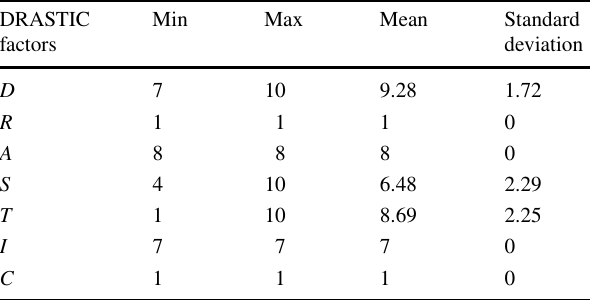
Table 9 Statistics on sensitivity to removing one DRASTIC param- eter Parameter of sensitivity